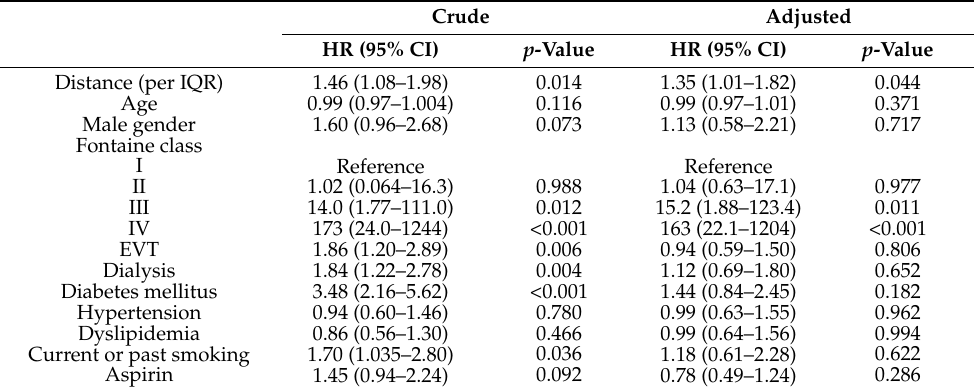
Table 2. Cox proportional hazards model for lower extremity